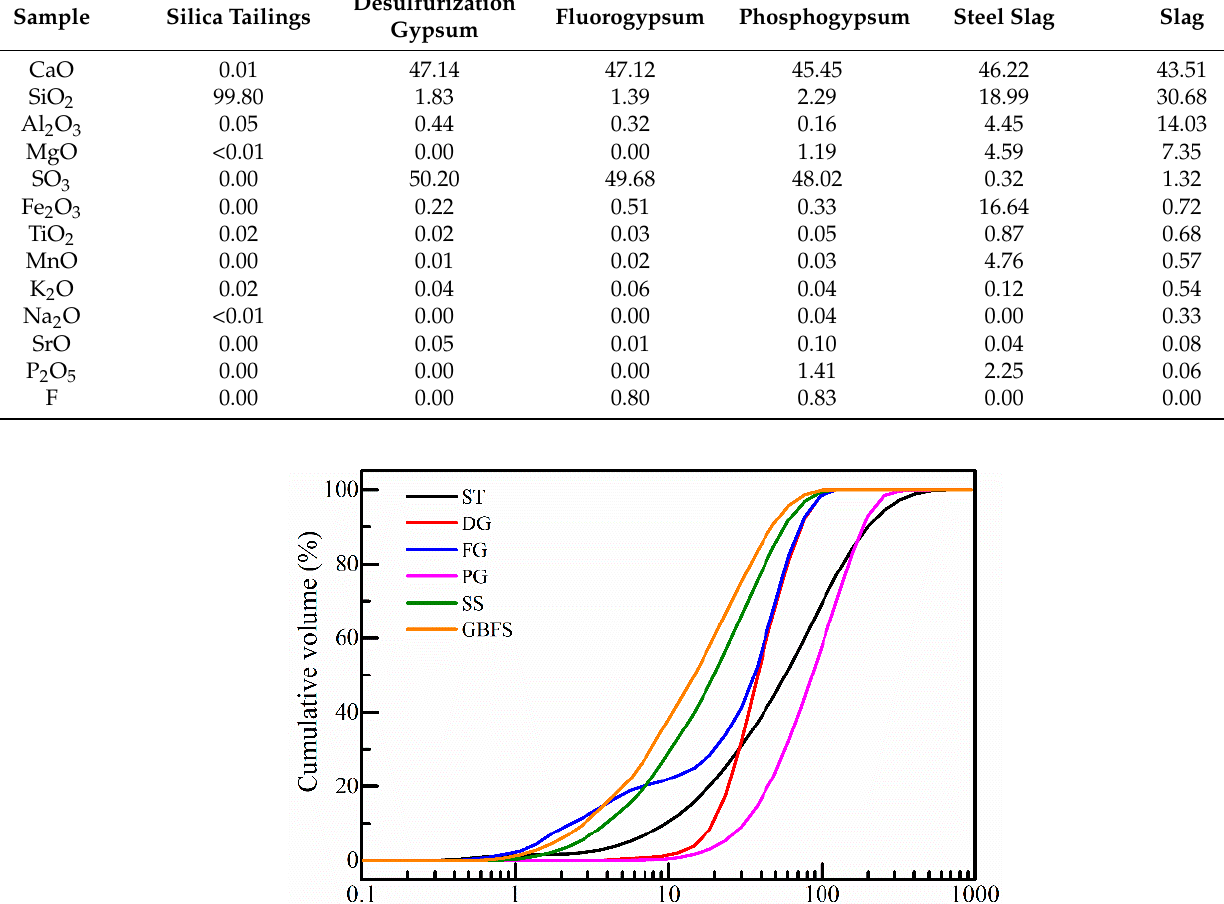
Table 1. Chemical composition of raw materials used in the experiment.